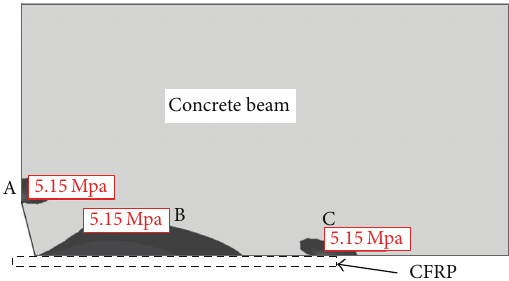
Figure8:Thedistributionofthemaximumtensilestressintheplain concrete beam strengthened with externally bonded CFRP.